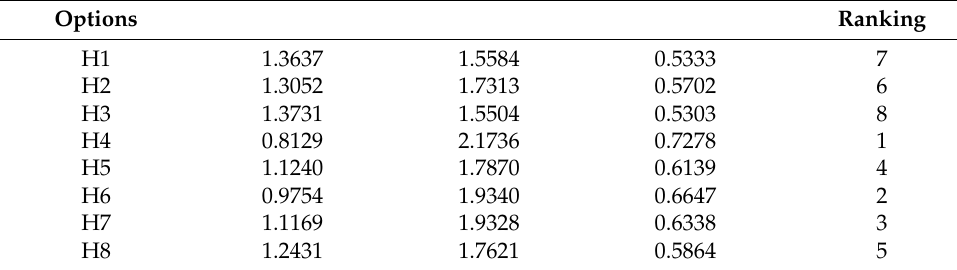
Table 10. Ranking orders of IPF-TOPSIS for MSW treatment